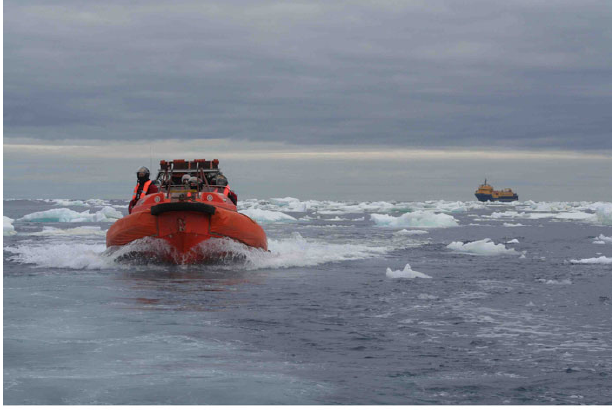
Fig. 3 . International cooperation has improved